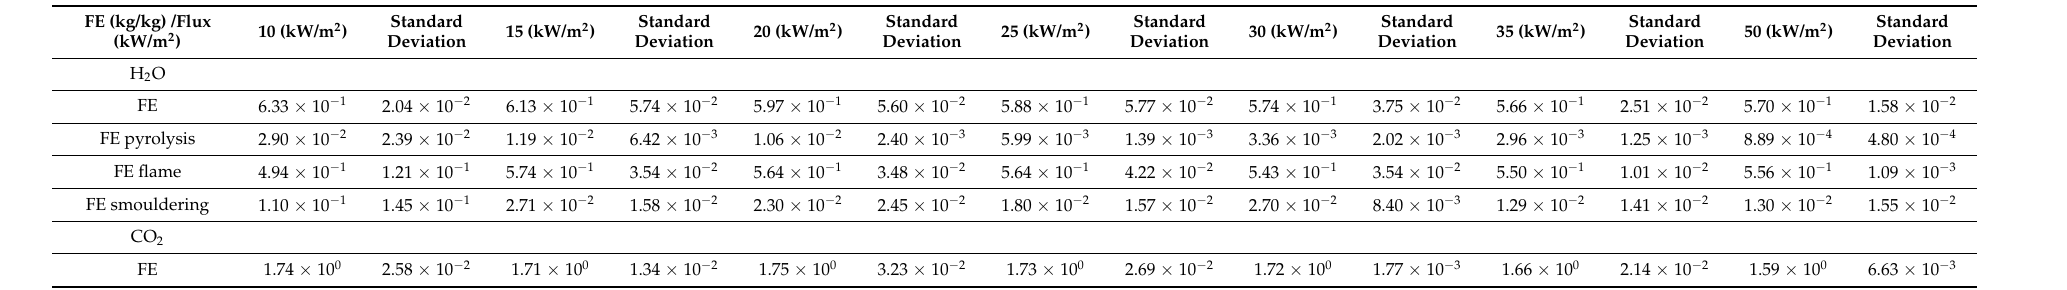
Table A2. EF for gas and aerosols for thermoplastic